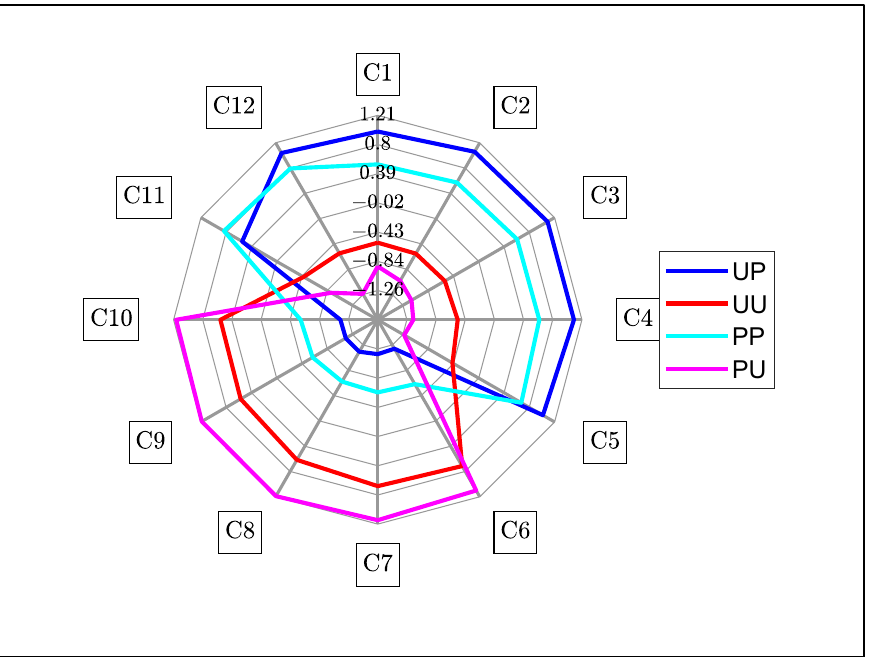
Figure 7. Aquagram for all configurations. Blue—Unpeeled Polarized, Red—Unpeeled Unpolarized, Cyan—Peeled Polarized and Magenta—Peeled Unpolarized kiwifruit.